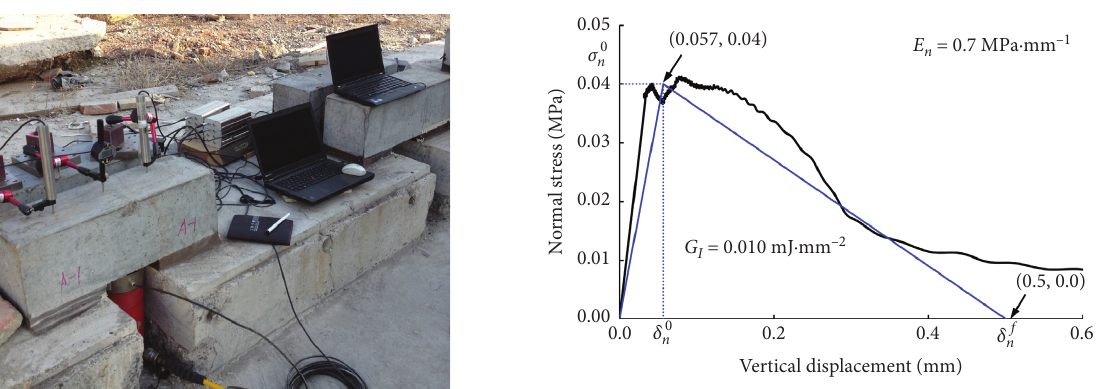
Figure 8: Force-displacement curve of the vertical push plate test.